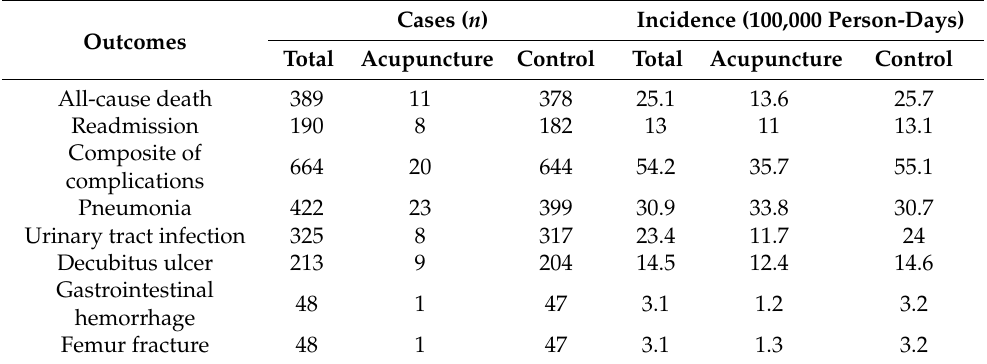
Table 2. Number of cases and incidence of outcomes in the acupuncture and control groups.